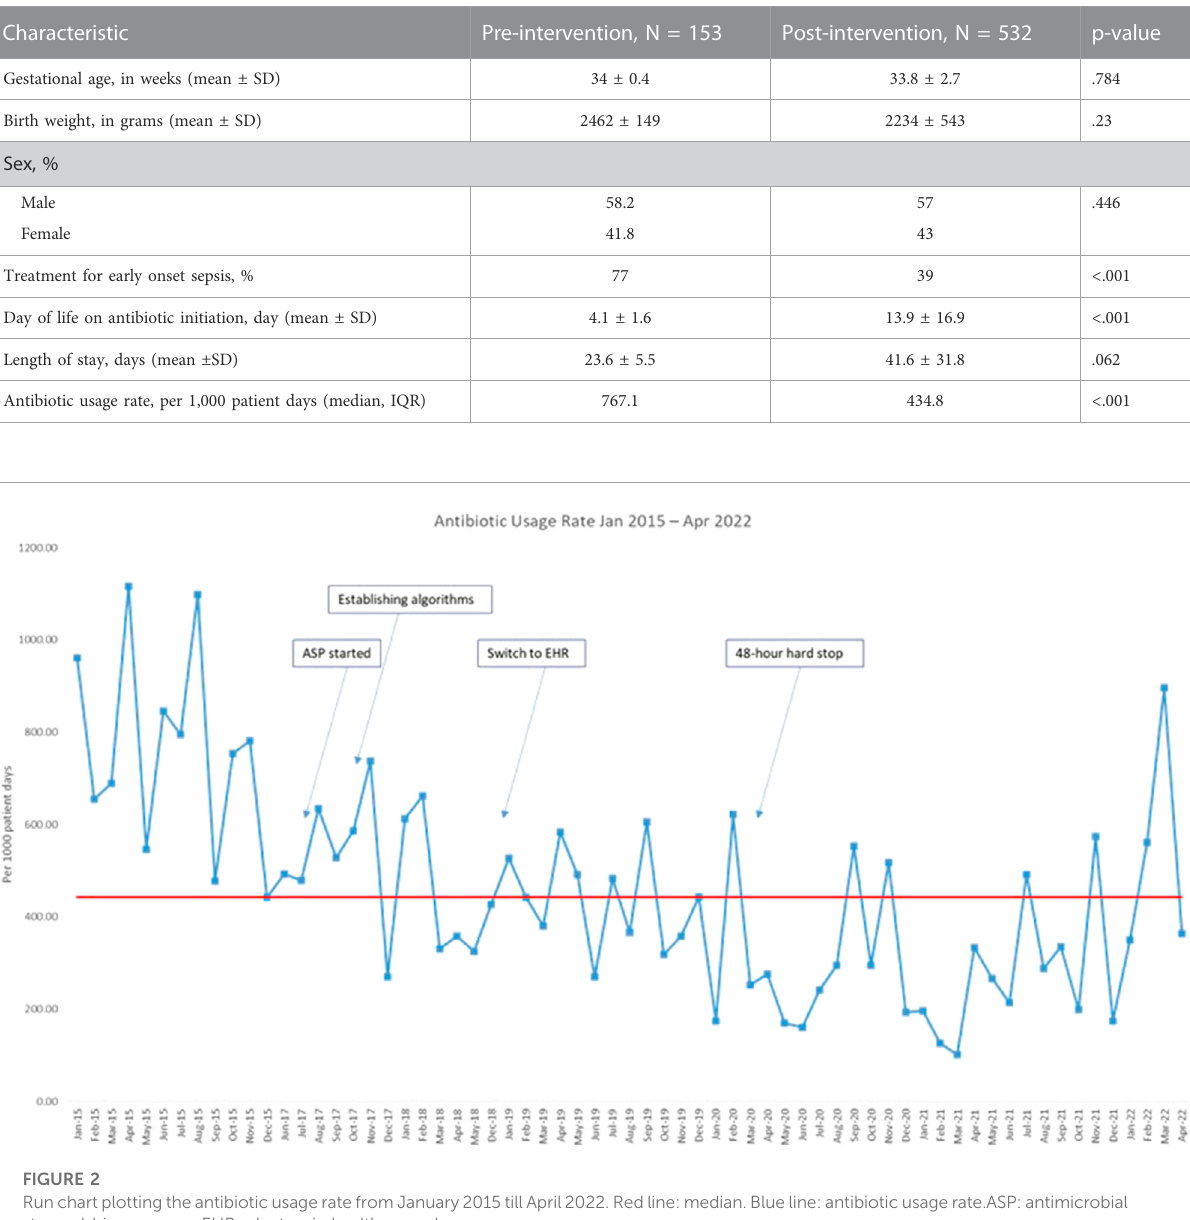
FIGURE 2 RunchartplottingtheantibioticusageratefromJanuary2015tillApril2022.Redline:median.Blueline:antibioticusagerate.ASP:antimicrobial stewardship program; EHR: electronic health